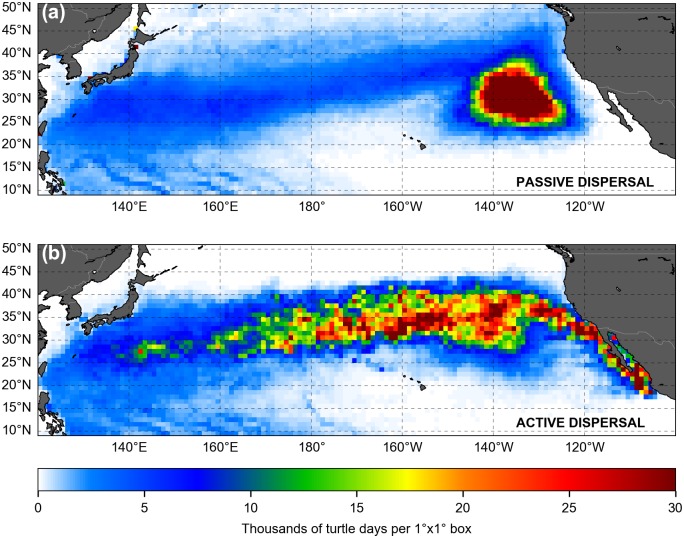
Number of turtle days in 1°x1° boxes for (a) the passive and (b) the active dispersal simulations.